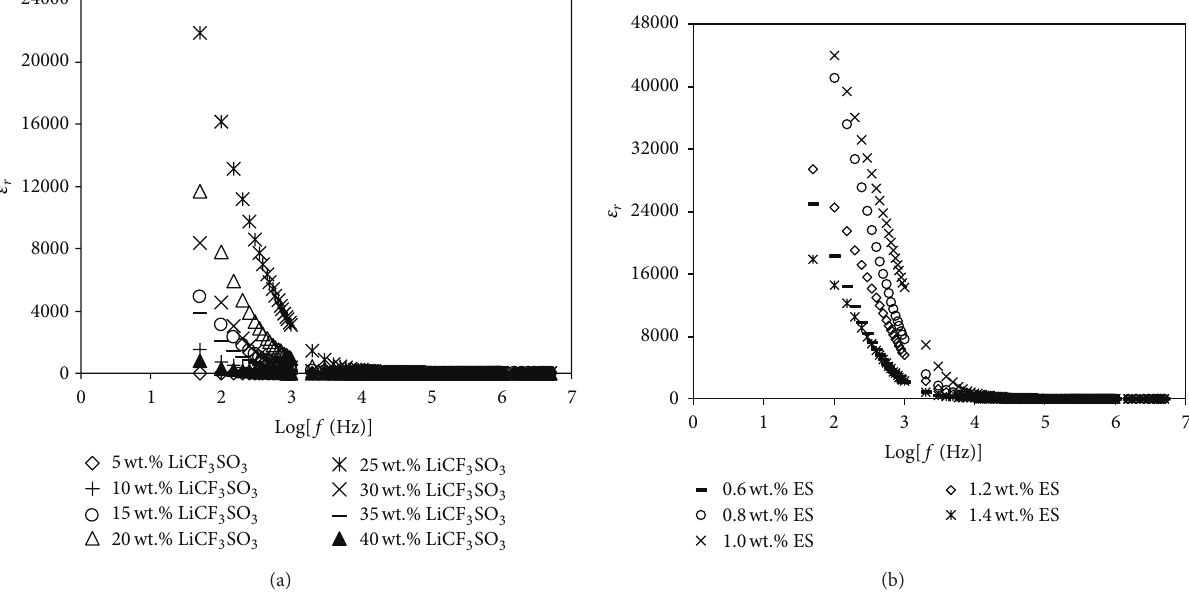
Figure 7: The frequency dependence of dielectric constant, 𝜀 𝑟 , at room temperature: (a) salted system and (b) plasticized system for selected sample.